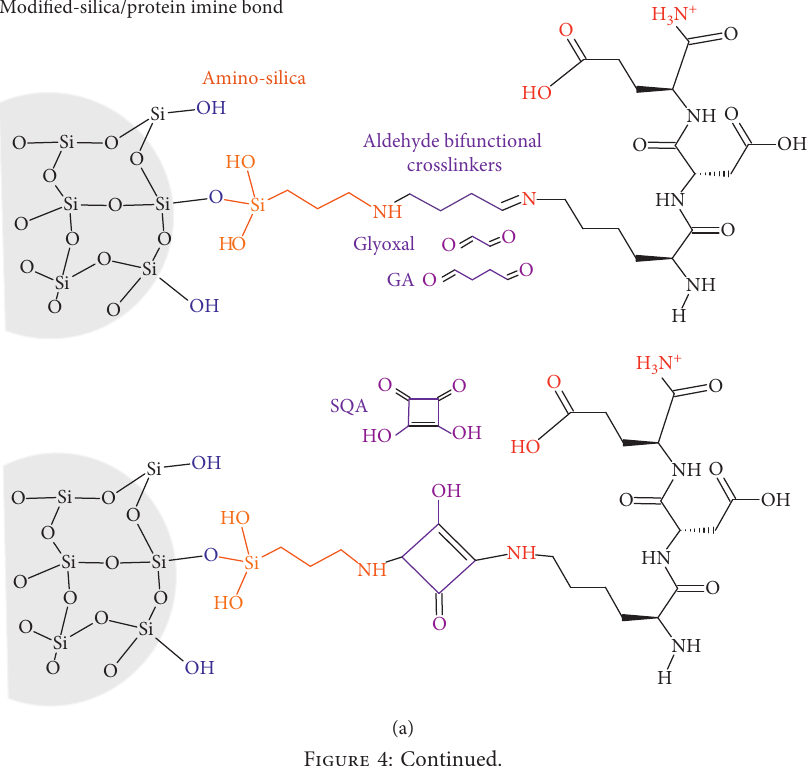
Figure 3: Physical interactions of pure (a,b) and silylated silicas (c,d) with polysaccharides and proteins by direct or mediated mechanisms. Modified-silica/protein imine bond